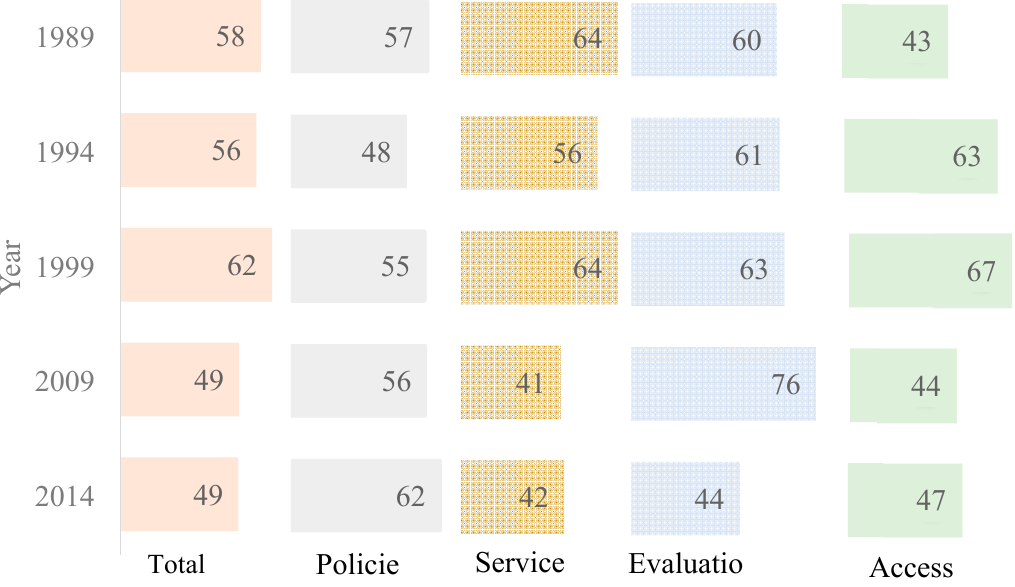
Figure 2. Trend in Family Planning Effort Index scores (FPE), 1989–2014.